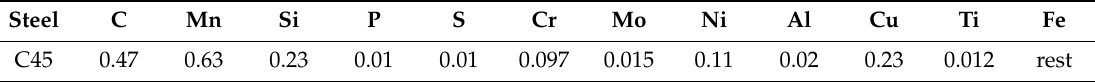
Figure 2. Schematics of: ( a ) cross-wedge rolling (CWR); ( b ) helical-wedge rolling (HWR). Table 1. Percentage of chemical elements for C45 steel determined by emission